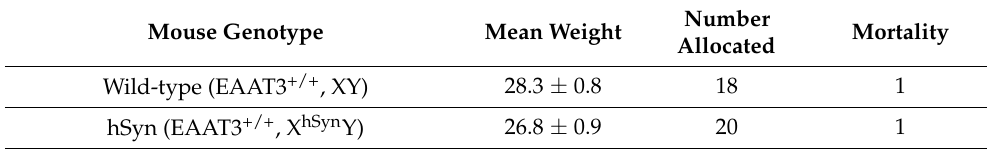
Table 1. Mouse genotype distribution and